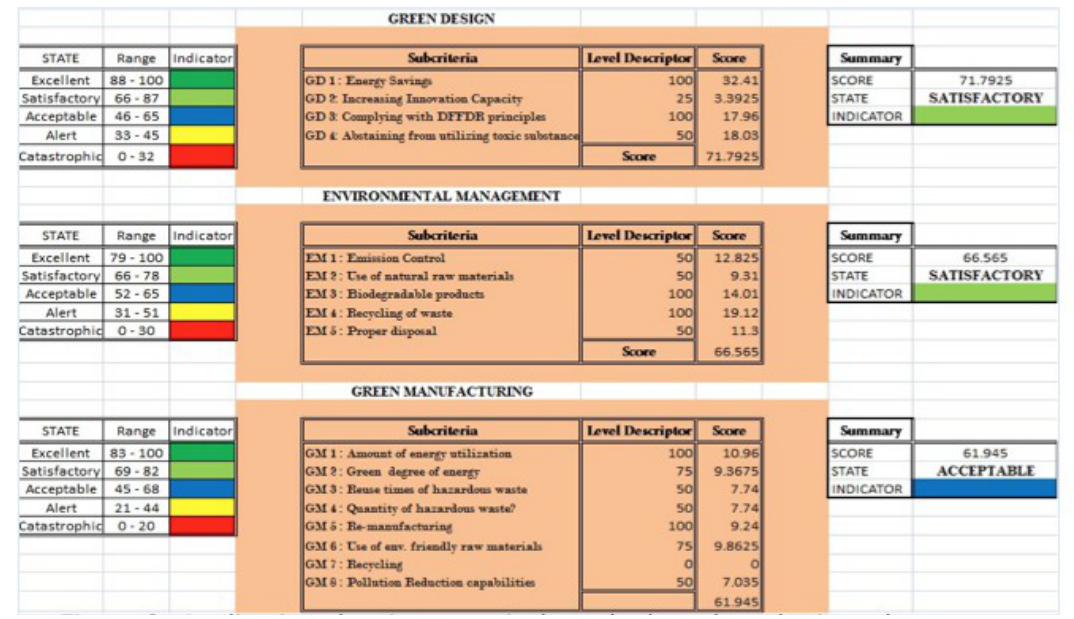
Figure 8. Application showing appraisal results based on the input/response